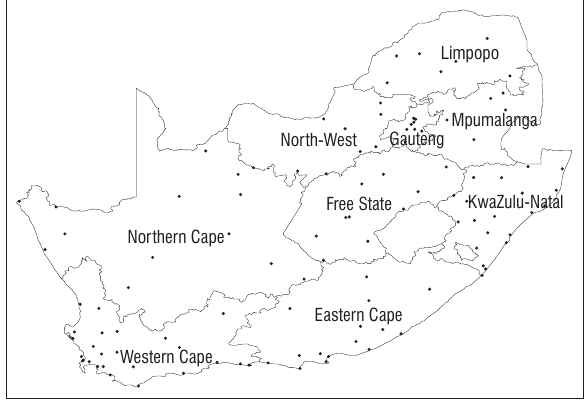
Figure 1: Positions of South African Weather Service weather stations used in the wind hazard analyses.